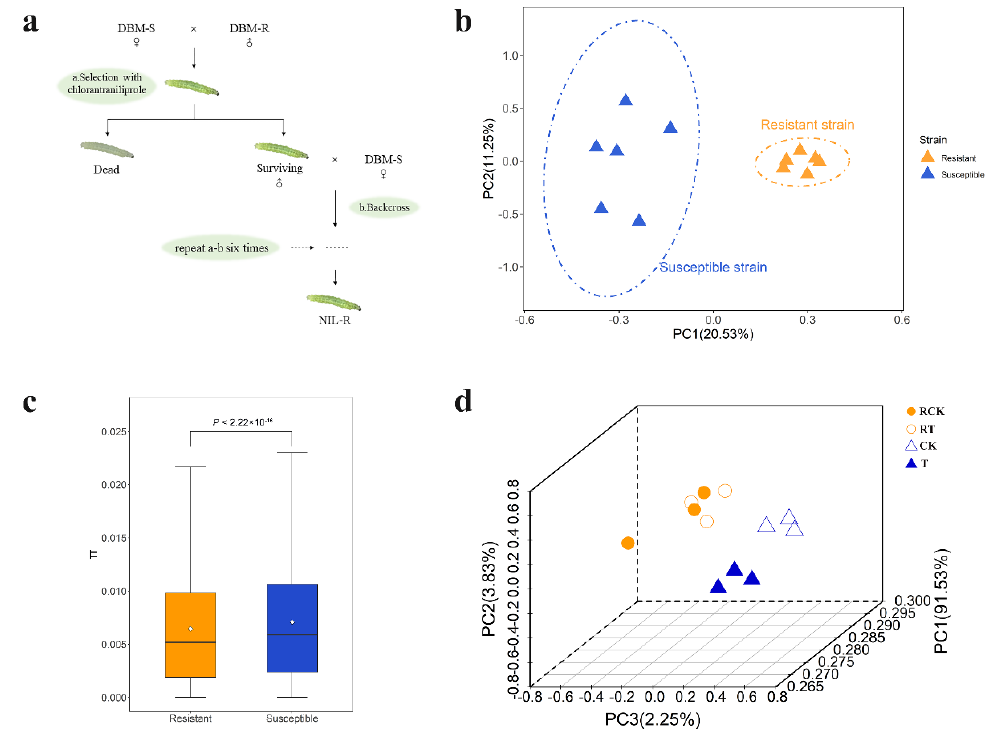
Figure 1. Genetic differentiation between susceptible and resistant strains of Plutella xylostella . ( a ) Construction of near-isogenic Plutella xylostella strains resistant to chlorantraniliprole. ( b ) Principal component analysis of SNPs. ( c ) Significant difference in population nucleotide diversity (θ π ), as evaluated using the t -test ( P < 2.22 × 10 − 16 ). ( d ) Principal component analysis of gene counts. Two colors represent two strains of Plutella xylostella , orange for the resistant strain and blue for the susceptible strain. Different graphs represent samples, RCK, Resistant stain without treatment by chlorantraniliprole (LC 50 ); RT, Resistant stain after treated with chlorantraniliprole (LC 50 ); CK, Susceptible strain without exposure to any insecticide; and T, Susceptible strain exposed to chlorantraniliprole (LC 50 ).